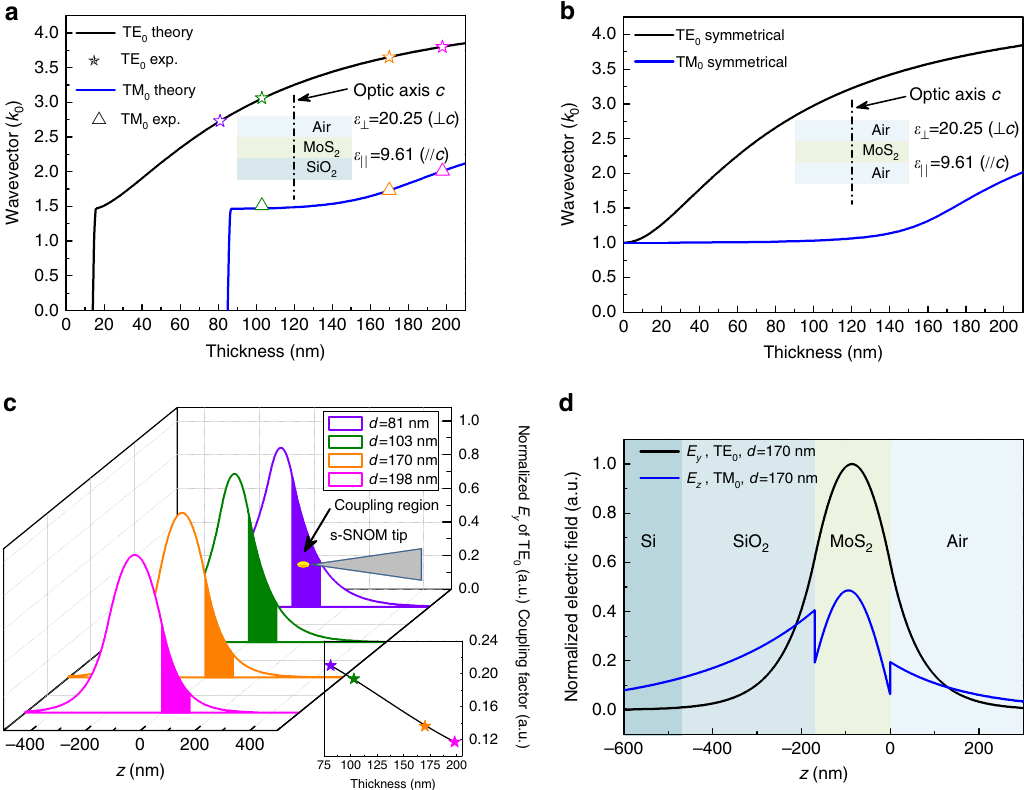
Fig. 3 Analyses of experimental results. a Theoretical and experimental thickness dispersions of the fundamental ordinary (TE 0 ) and extraordinary (TM 0 ) waveguide modes in the air – MoS 2 – SiO 2 three-layer waveguide, the superstrate air, and the substrate SiO 2 are assumed to be semi-in fi nite in the calculations. b Theoretical thickness dispersions of the fundamental ordinary (TE 0 ) and extraordinary (TM 0 ) waveguide modes in free-standing MoS 2 nano fl akes. c Evolution of mode pro fi les associated with the fundamental ordinary waveguide mode (TE 0 ), the inset shows a decreasing coupling factor between the tip-induced hot spot and the waveguide mode with increasing sample thickness. We assume the interval 0 nm ≤ z ≤ 100 nm to be the ef fi cient coupling region since the tip-tapping amplitude is set to 50 nm in the experiments. d Normalized mode pro fi les of the fundamental ordinary (TE 0 ) and extraordinary (TM 0 ) waveguide modes for the 170-nm-thick MoS 2 sample indicate that the extraordinary mode retains stronger electric fi eld at the virtual SiO 2 /Si interface and tends to leak out through the SiO 2 layer. The calculations in c and d use the same air – MoS 2 – SiO 2 three-layer waveguide model as in